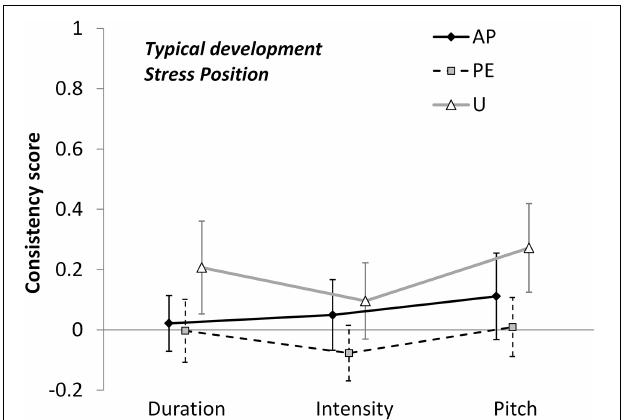
FIGURE 5 | Consistency scores by Typically Developing children are plotted against Parameter, as a function of Stress Position (AP, antepenultimate; PE, penultimate; or U, ultimate). Error bars are 95% confidence